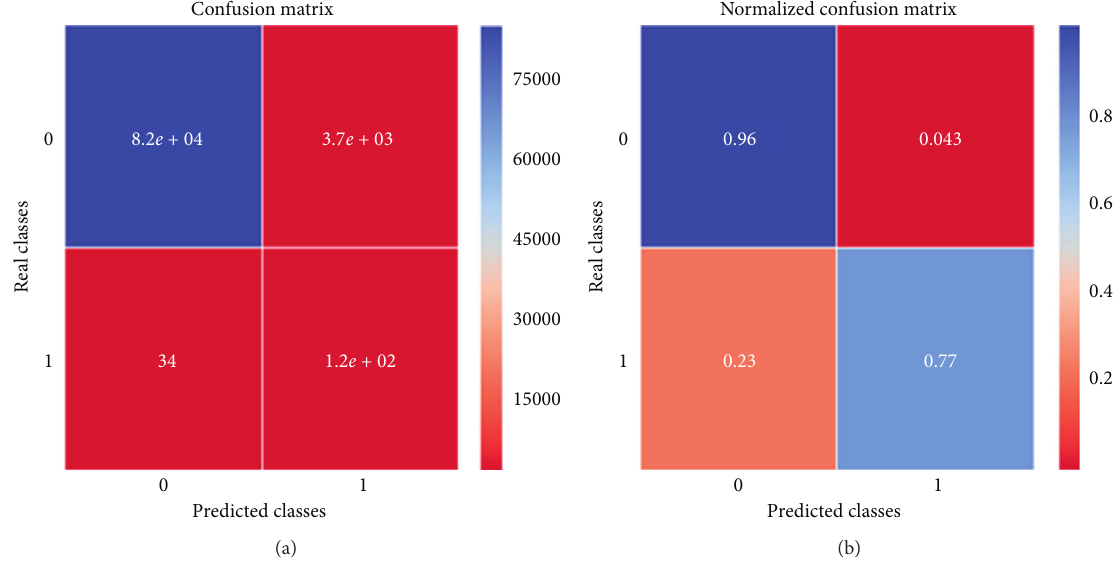
Figure 9: (a) Confusion matrix and (b) normalized confusion matrix for ADASYN+LSTM.